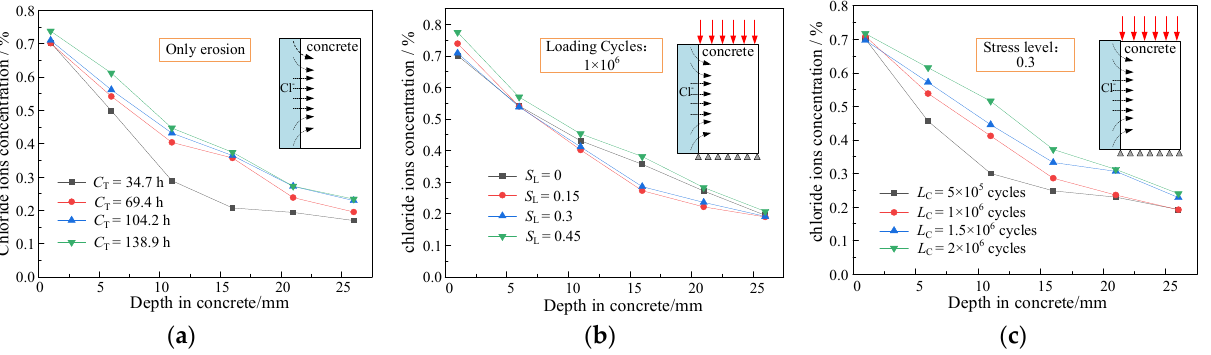
Figure 6. Test results of chloride concentration: ( a ) only erosion; ( b ) different loading cycles; and ( c ) different stress levels.